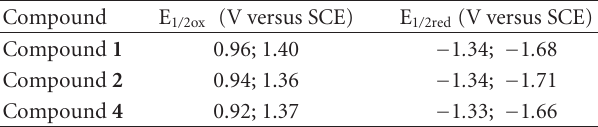
Table 1: Redox data of dimethoxy derivatives (a)